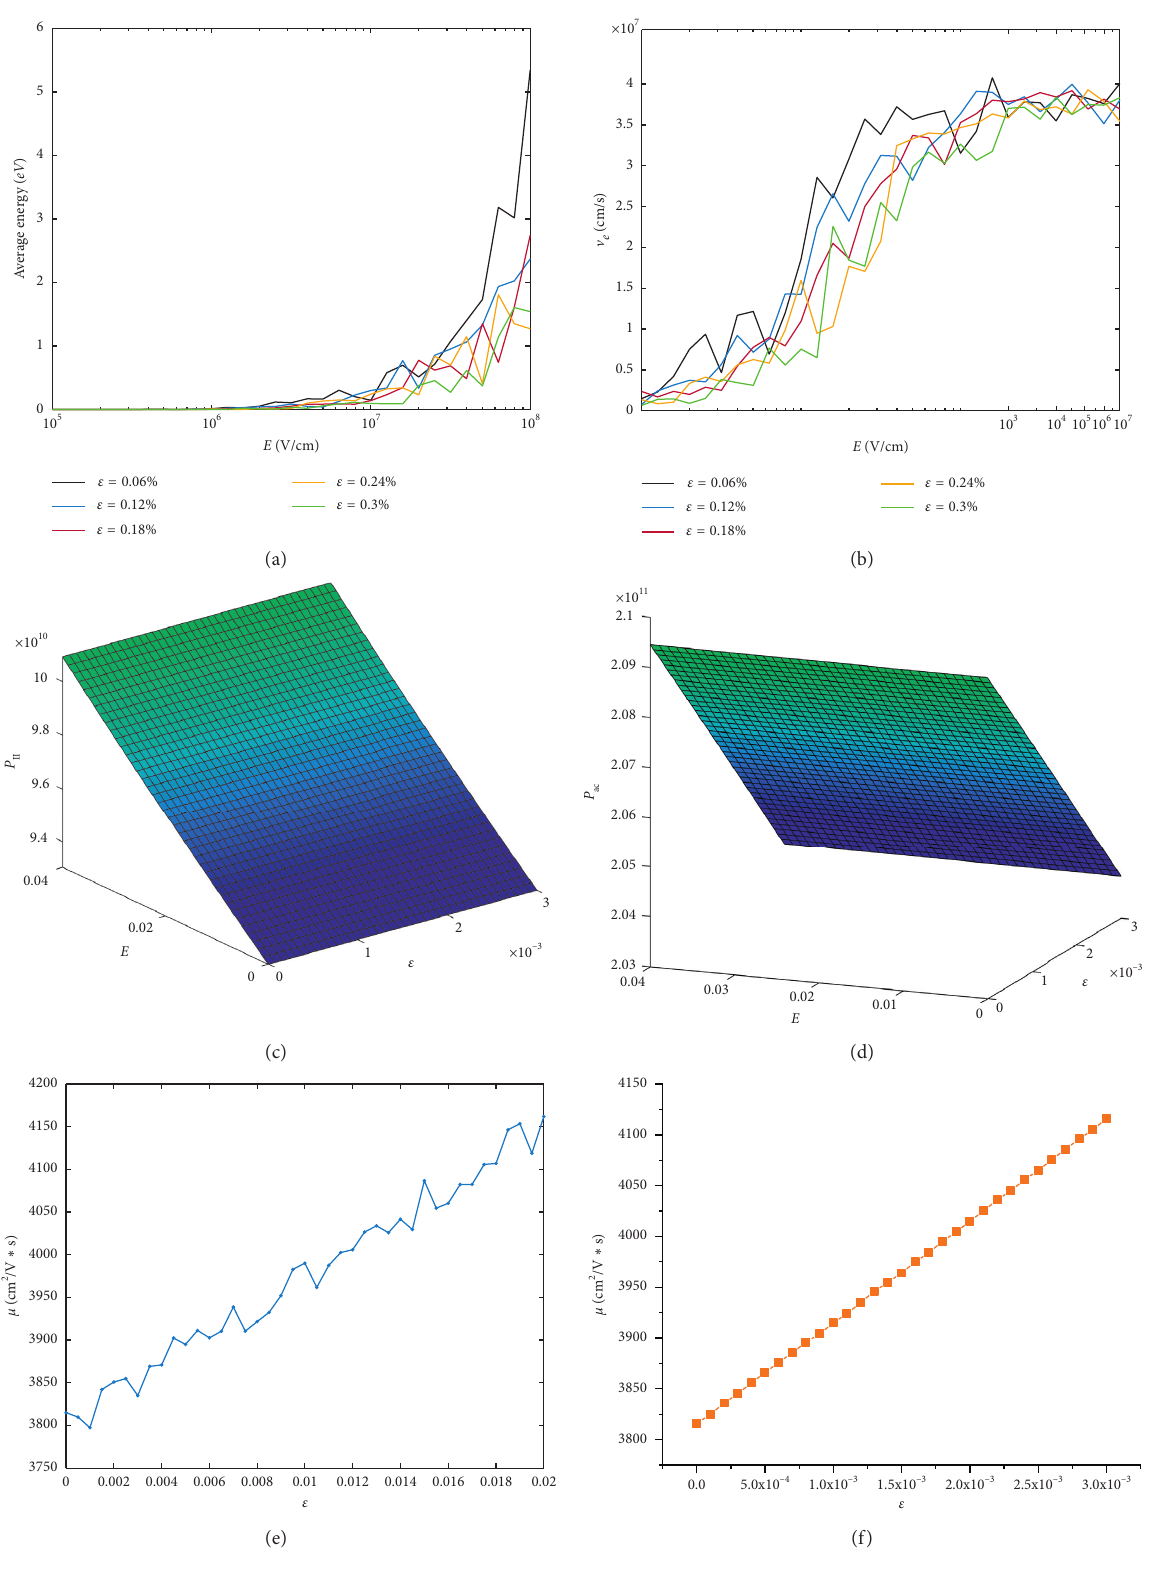
Figure 4: s-Ge/Si Monte Carlo and electron scattering mechanism simulation carrier transport results. (a) The average electron energy of s- Ge/Si under different strains varies with the applied electric field. (b) The average electron drift speed of s-Ge/Si under different strains varies with the applied electric field. (c) The relationship between the scattering rate of s-Ge/Si electron ionized impurities and the strain. (d) s-Ge/Si electronic acoustic phonon scattering rate as a function of strain. (e) s-Ge/Si average mobility changes with strain. (f) s-Ge/Si electron mobility as a function of